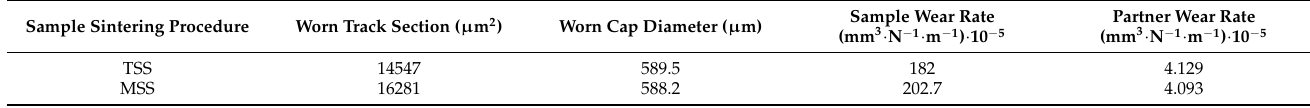
Figure 13. Sample obtained by MSS: ( a ) Worn track image (75X); ( b ) 3D image; ( c ) intensity profile. Table 4. The values for worn track sections and wear